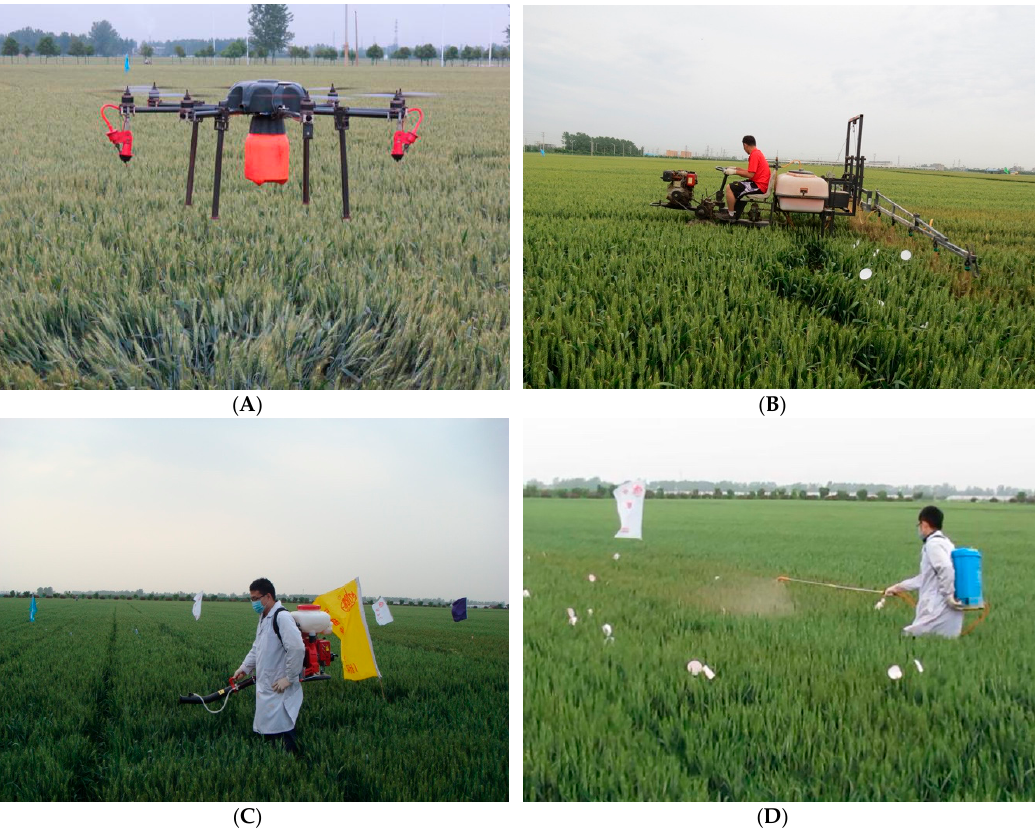
Figure 1. Four test sprayers: ( A ) 3WTXC8-5 six-rotor unmanned aerial vehicle (UAV) sprayer; ( B ) 3WX-280H self-propelled boom (SPB) sprayer; ( C ) WFB-18 knapsack mist-blower (KMB) sprayer; and ( D ) 3WBS-16A2 electric air-pressure knapsack (EAP) sprayer.